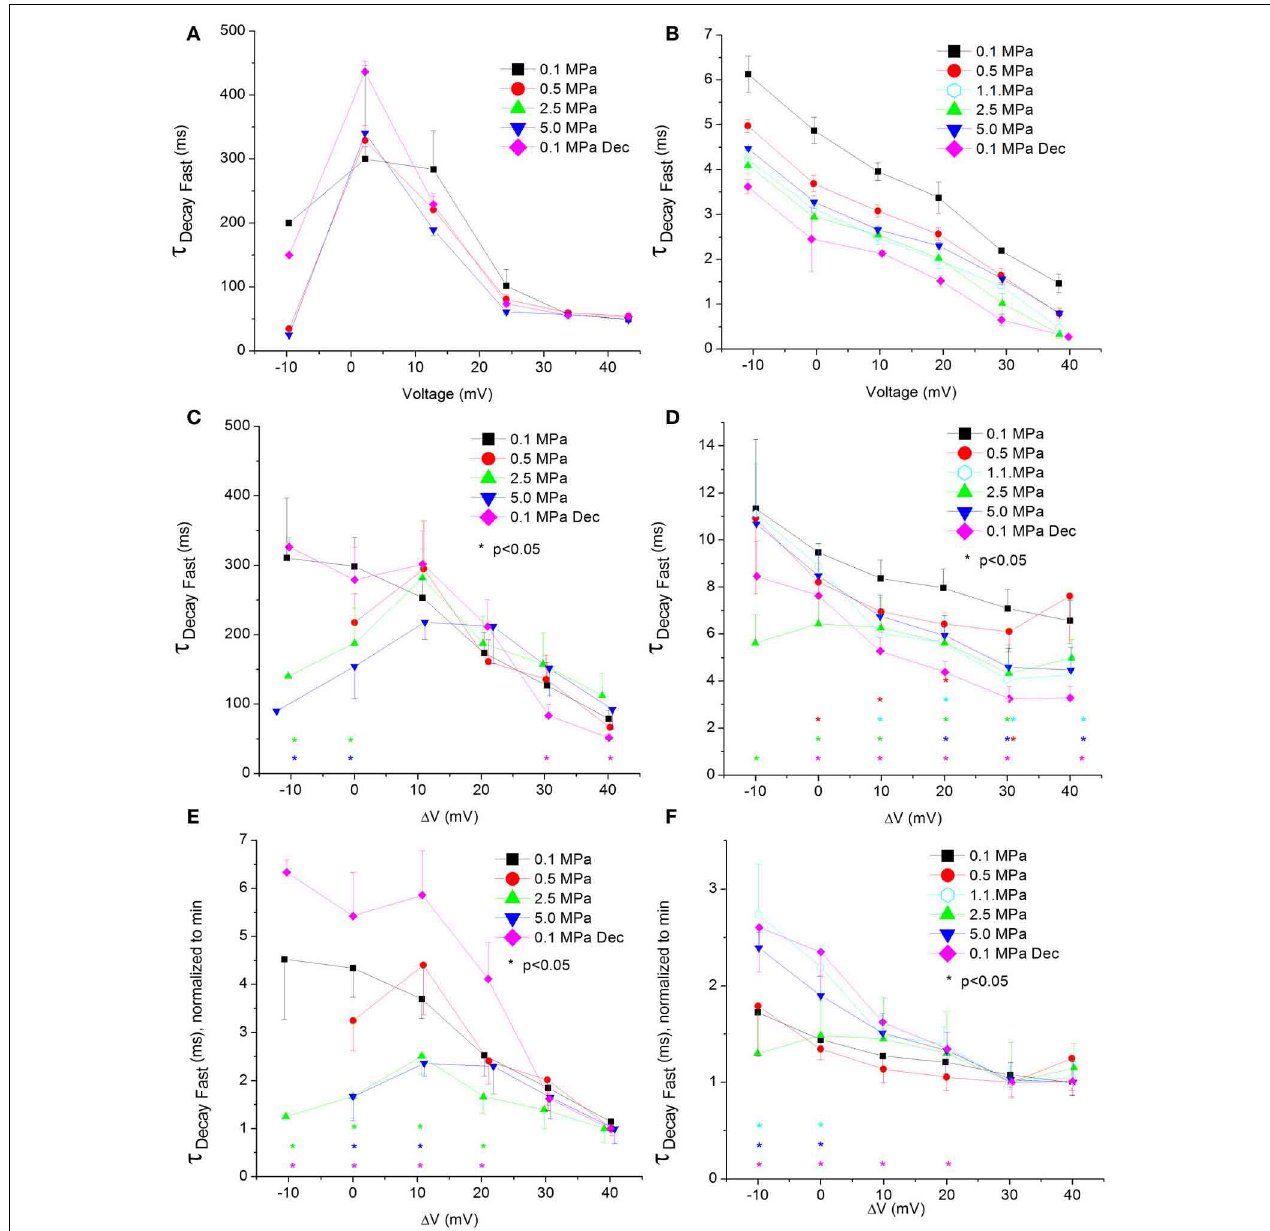
FIGURE 8 | Fast time constant of voltage- and time-dependent current inactivation ( Decay Fast ). (A,C,E) in Ca V 1.2 and (B,D,F) in Ca V 3.2 channels. (A,B) Decay Fast measured in a single oocyte. (C,D) Pooled data of the channels. (E,F) Normalized Decay Fast : each curve is